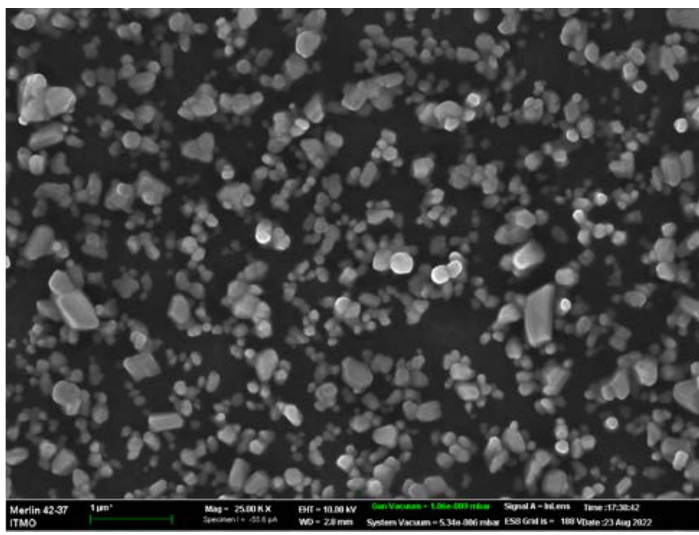
Figure 2. Scanning electron microscopy image of SERS substrate.